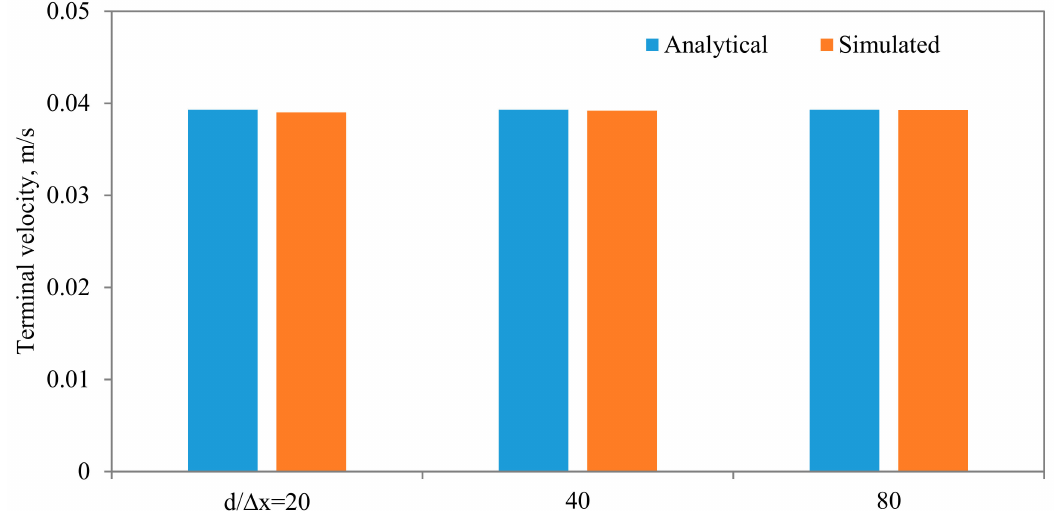
Figure 18. Comparisons between the terminal settling velocity and the simulated one for different spatial resolutions. In these simulations, the following parameters are held fixed: k x = d/L x = 4, µ f = 0.001 Pa · s, µ p = 1000 Pa ·